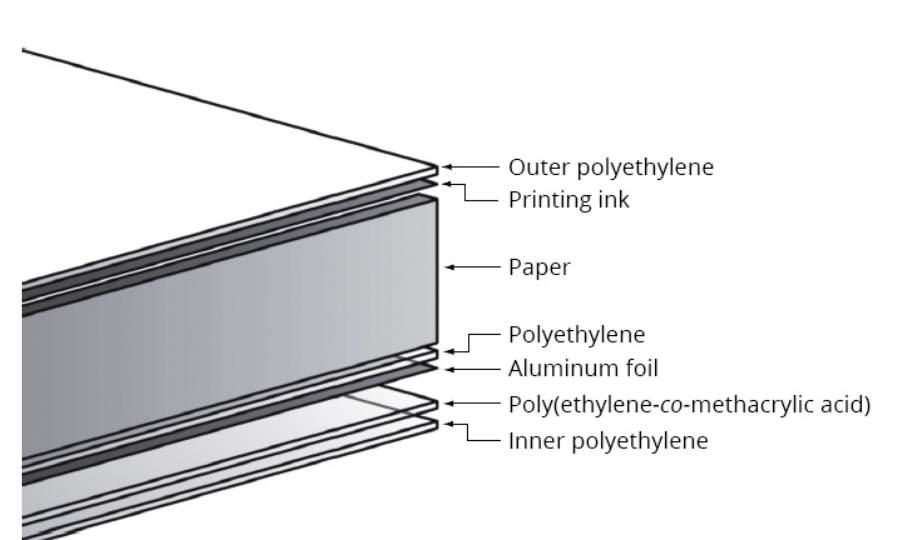
Figure 1. Typical structure of an aseptic carton.